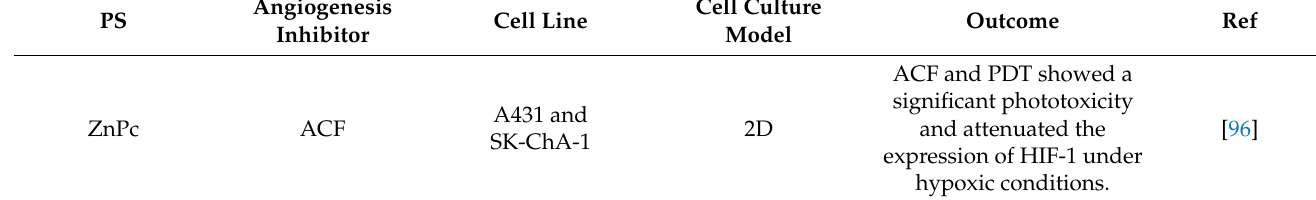
Table 6. Overview of studies that inhibited angiogenic factors to enhance PDT